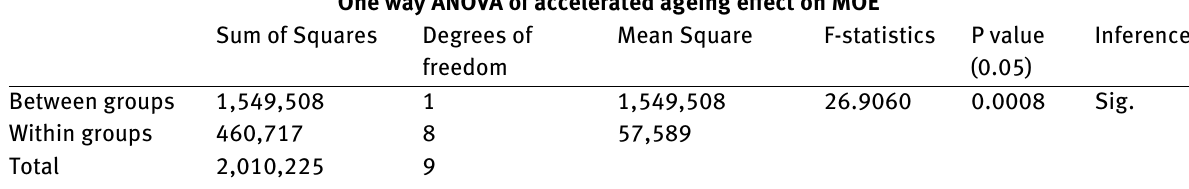
Table 3: One way ANOVA of dimensional stability properties